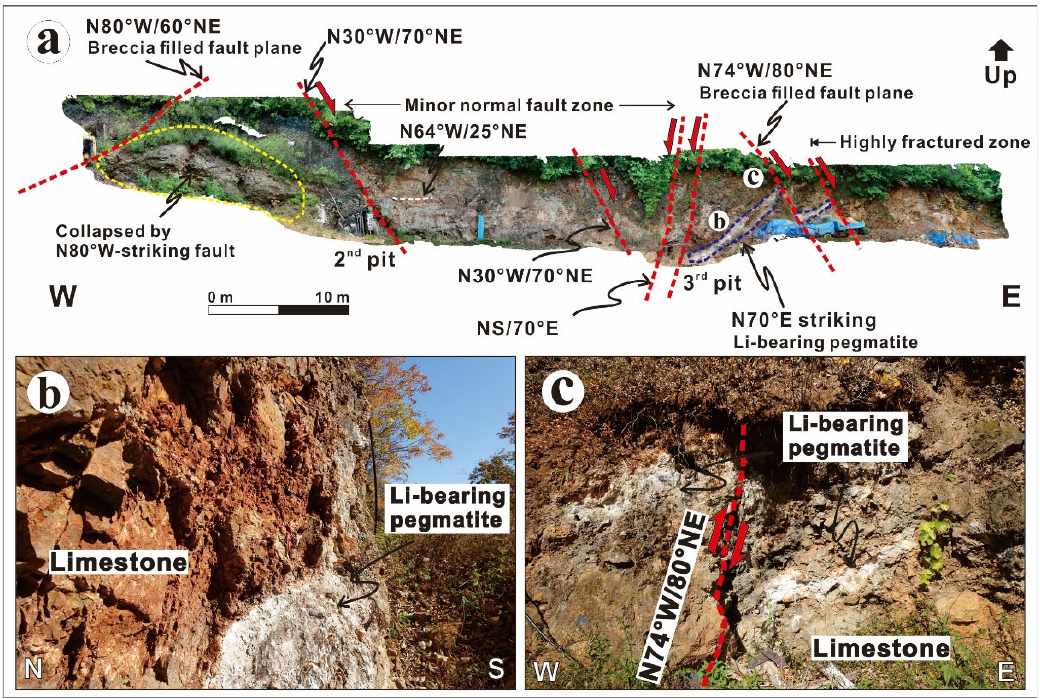
Figure 6. Eastern slope and rare ‐ element pegmatite (REP) bodies (Pgt 5, around pit 3) of the Boam deposit. ( a ) Access to pits 2 and 3 is restricted owing to collapse, and the western side of pit 2 has collapsed as a result of the N80° W/60° NE ‐ striking fault. The N–S ‐ and NW–SE ‐ striking faults developed between the two pits. ( b ) An N70° E ‐ striking REP body is observed on the upper slope of pit 3. ( c ) The N74° W/80° NE ‐ striking fault has displaced Pgt 5 (northern block down).